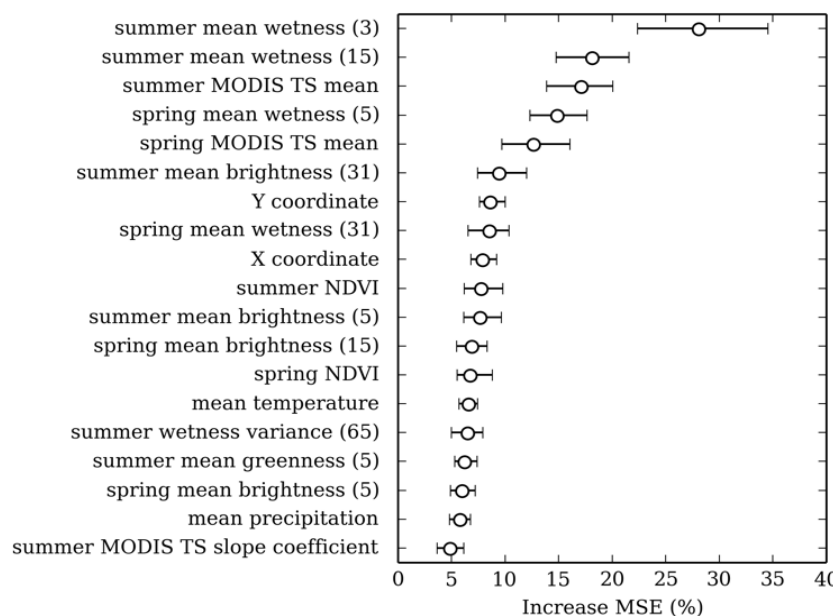
Figure 2. Relative importance of the 18 variables selected for the final random forest